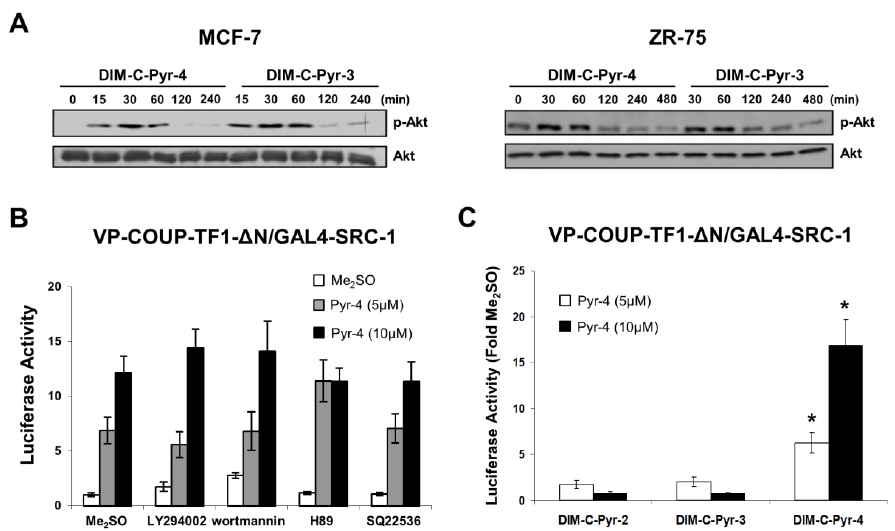
Figure 4. Ligand-induced interactions of the C-terminal domain of COUP-TFI with SRC-1. ( A ) Activation of PI3-K by DIM-C-Pyr-4 and DIM-C-Pyr-3. MCF-7 or ZR-75 cells were treated with 15 µ M DIM-C-Pyr-4 or DIM-C-Pyr-3 for up to 480 min, and phospho-Akt and Akt protein expression was determined by Western blot analysis of whole-cell lysates as described in the Materials and Methods section. ( B ) Effects of kinase inhibitors on DIM-C-Pyr-4-induced SRC-1-COUP-TFI- ΔN interactions. MCF-7 cells were transfected with GAL4-SRC-1/GAL4-luc and VP-COUP-TFI- ΔN, treated with Me 2 SO or DIM-C-Pyr-4 alone or in combination with kinase inhibitors as described above, and luciferase activity was determined as described in the Materials and Methods section. Results are expressed at means ± SE for three replicate determinations for each treatment group. ( C ) Structure-dependent interactions of GAL4-SRC-1 and COUP-TFI- ∆ N. MCF-7 cells were transfected as described in ( B ), treated with Me 2 SO, DIM-C-Pyr-4, DIM-C-Pyr-3 or DIM-C-Pyr-2, and luciferase activity determined as described in the Materials and Methods section. Results are means ± SE for triplicate determinations, and significant ( p < 0.05) induction is indicated by an asterisk. 3.3. DIM-C-Pyr-4 Activation of Egr-1 is Dependent on COUP-TFI and Sp Proteins Overexpression of COUP-TFI in rat urogenital mesenchymal (rUGM) cell lines resulted in induction of Egr-1 (27), and results in Figures 5A and 5B show that 5 μM DIM -C-Pyr-4 induced Egr-1 protein in MCF-7 and ZR-75 breast cancer cells, respectively. Induction was observed within 4 h and persisted for up to 12 h after treatment. DIM-C-Pyr-4 also induced a concentration-dependent increase in Egr-1 mRNA levels in MCF-7 (Figure 5C) and ZR-75 (Figure 5D) cells after treatment for 4 h.